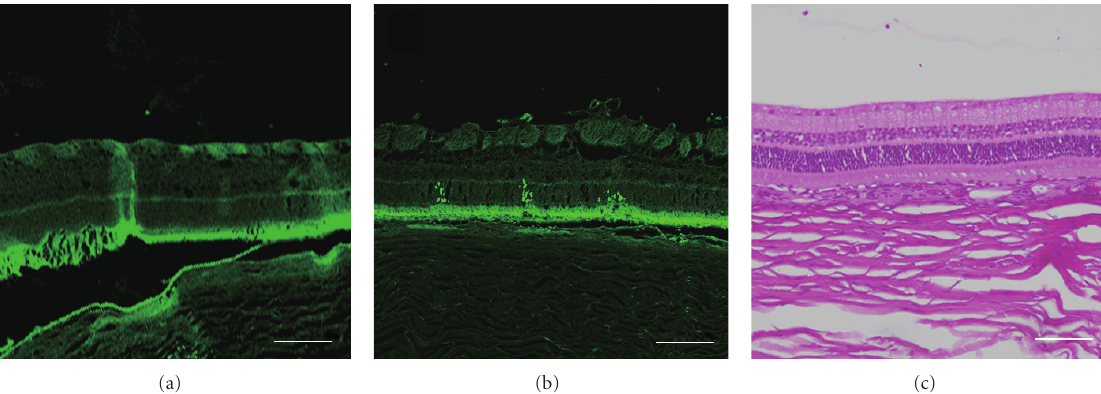
Figure 2: (a) No-GFP positive cells were observed in the control (plasmid + BL without US), (b) In the group treated with plasmid + BL + US, GFP-positive cells were observed exclusively in the area where US was exposed, and located in the outer nuclear layer. (c) H&E staining showed no obvious tissue damage. Bar equals 100 µ